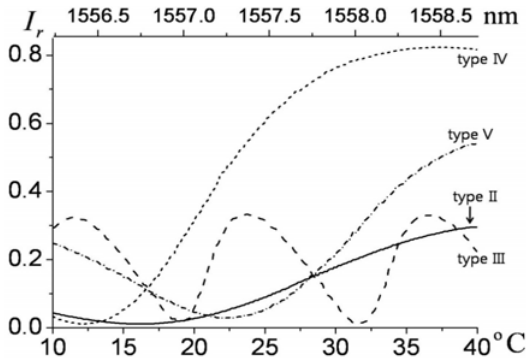
Figure 11. Measured reflectance fringes for probes II through V versus temperature-tuned wavelength within the 1550-nm